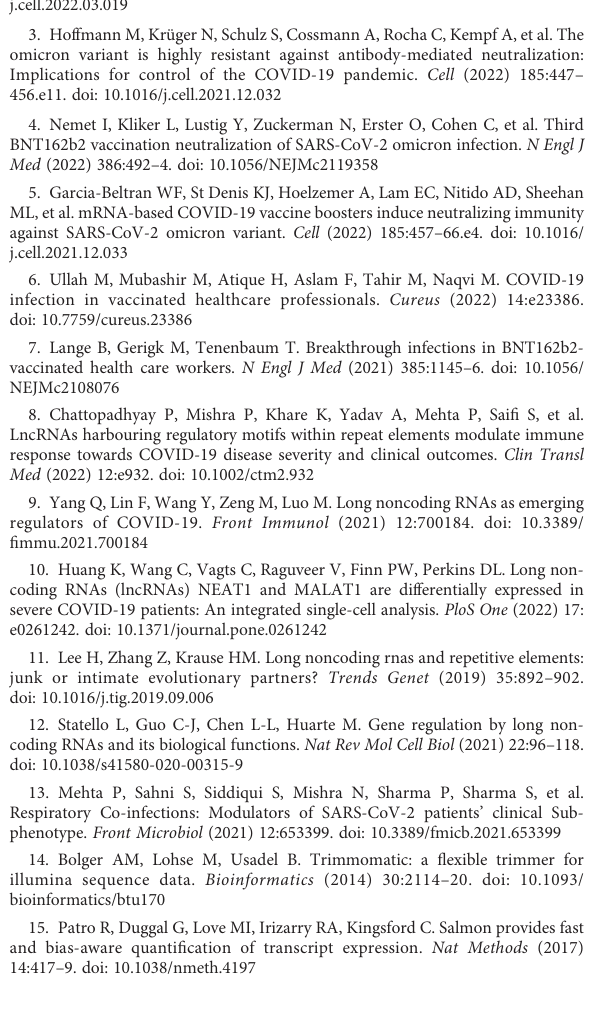
SUPPLEMENTARY TABLE S2 Differential expression of lncRNAs between VBT and unvaccinated. SUPPLEMENTARY TABLE S3 Differential expression of mRNAs between VBT and unvaccinated. SUPPLEMENTARY TABLE S4 Pearson correlation analysis of DE lncRNAs and mRNAs. SUPPLEMENTARY TABLE S5 GSEA of network interacting genes. SUPPLEMENTARY TABLE S6 Pathway enrichment of network interacting lncRNAs.